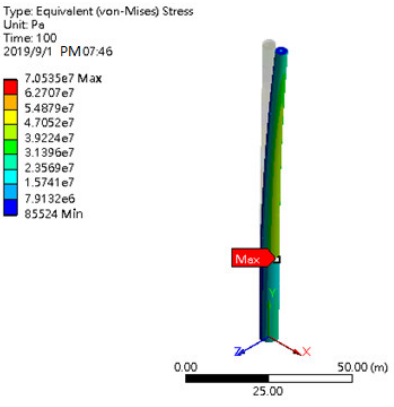
Figure 30. The location of the maximum stress occurred in the OWT.